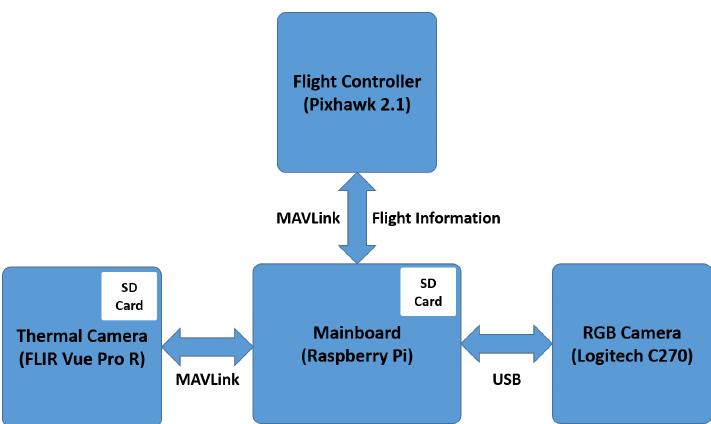
Figure 3. Block diagram of proposed drone system.